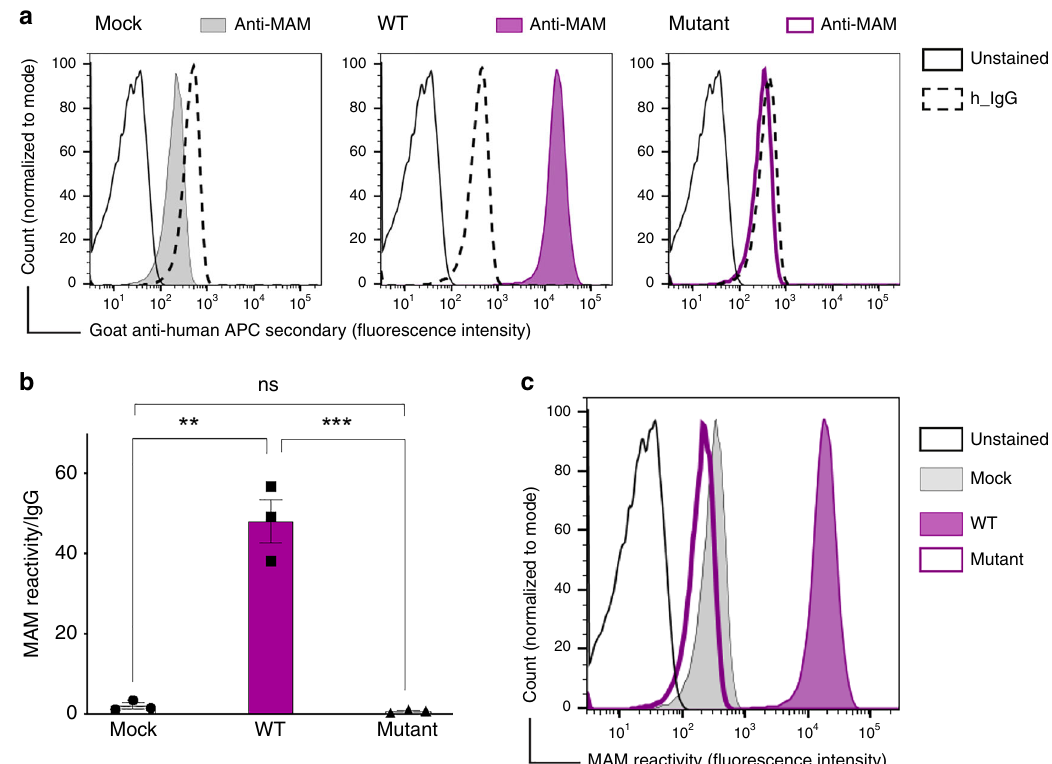
Fig. 3 EMP3 transfection causes MAM expression in Daudi cells. a Flow cytometry analysis showing establishment of MAM expression in Daudi cells. The representative histogram shows IgG (negative control) and MAM reactivity following transfection of Daudi cells with either pEF1 α -IRES-ZsGreen1 empty vector (mock), EMP3 wild-type (WT) or EMP3 mutant containing a premature stop codon (c.123 C > G, p.Tyr41Ter). b Overexpression of EMP3 in Daudi cells shown by mean fl uorescent intensity from three independent experiments; MAM expression is shown as a ratio between MAM reactivity and isotype control (IgG) reactivity in Daudi cells transfected by either mock, EMP3 WT or EMP3 mutant vectors. ** P = 0.0011, *** P = 0.001 (two-tailed unpaired student t test). Error bars represent standard error of the mean (SEM). Source data are provided as a Source Data fi le. c The histogram shows MAM reactivity following transfection of Daudi cells with either mock, wild-type (WT) or EMP3 mutant compared to unstained